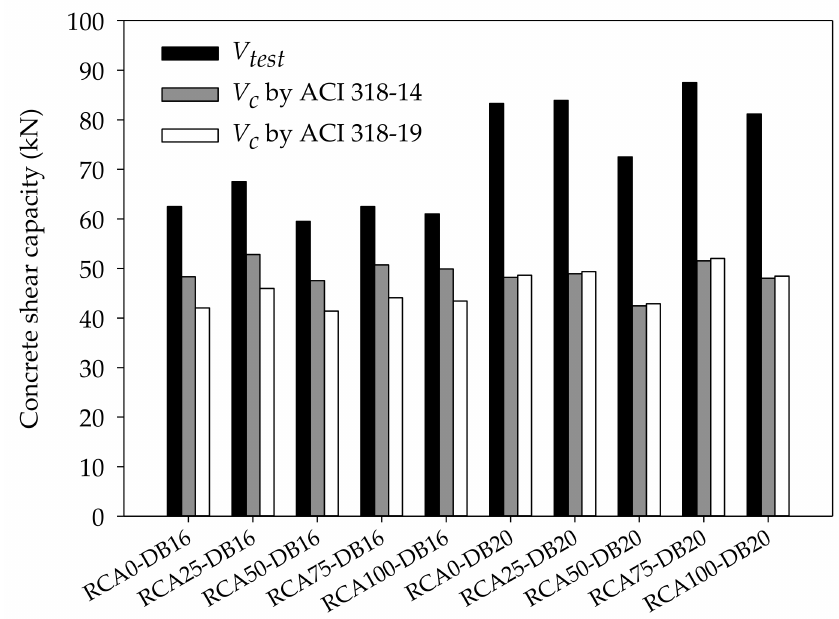
Figure 7. Comparisons of V test with V c from ACI 318-14 and ACI 318-19 predictions.